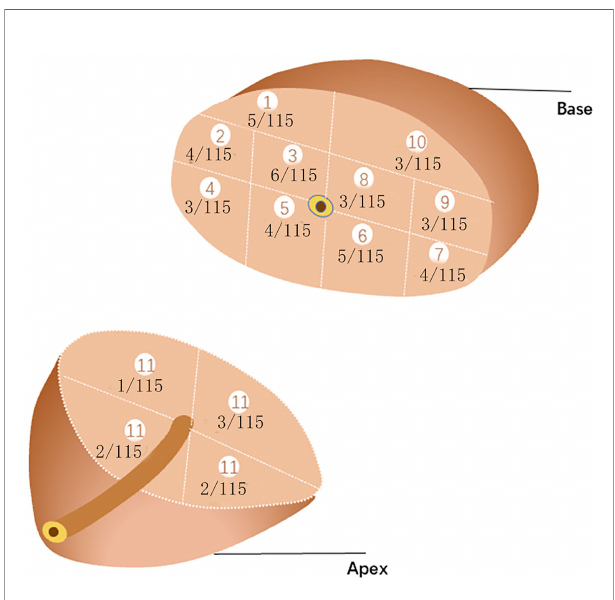
FIGURE 3 | PCa detection rate of each